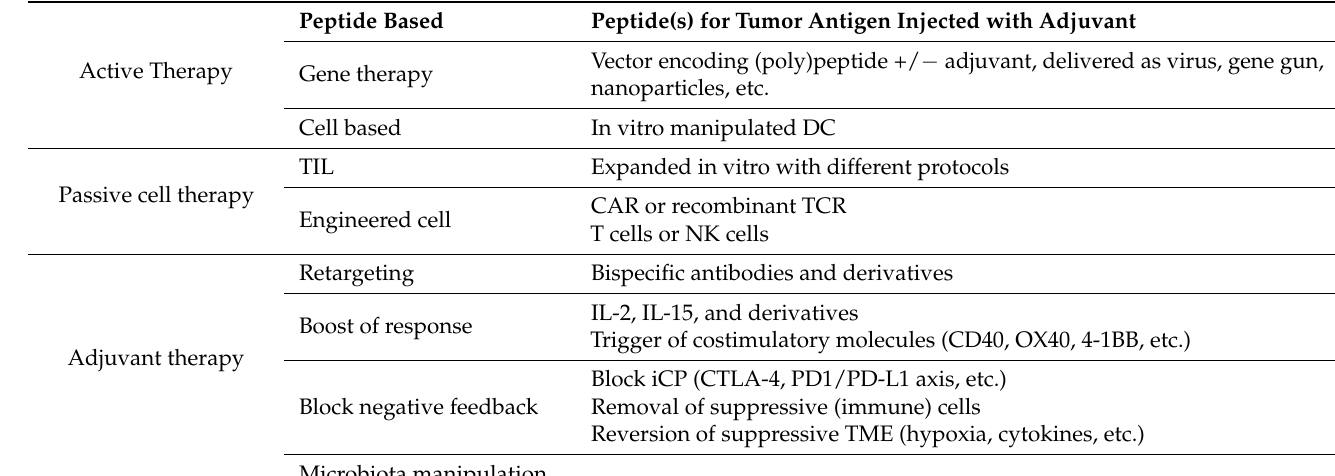
Table 1. Immunotherapy approaches used in clinical